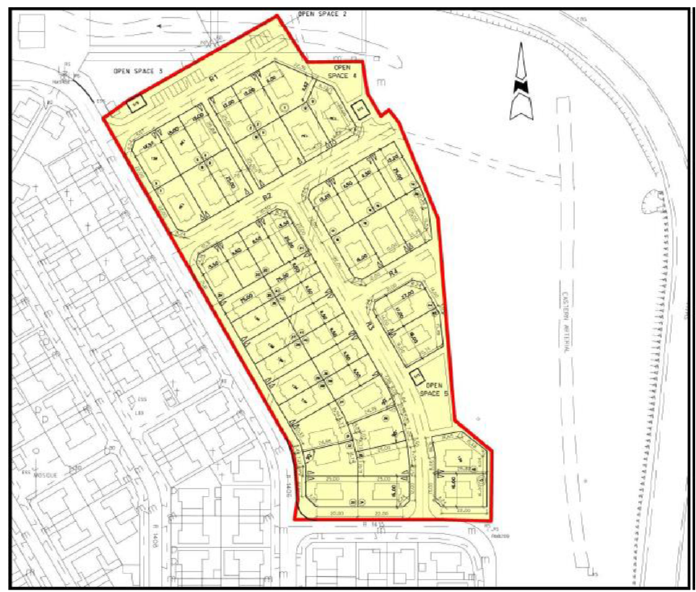
Figure 4. Hamad city, official layout. Source: Ministry of Housing, Bahrain. Table 2. Simulation inputs for the building’s